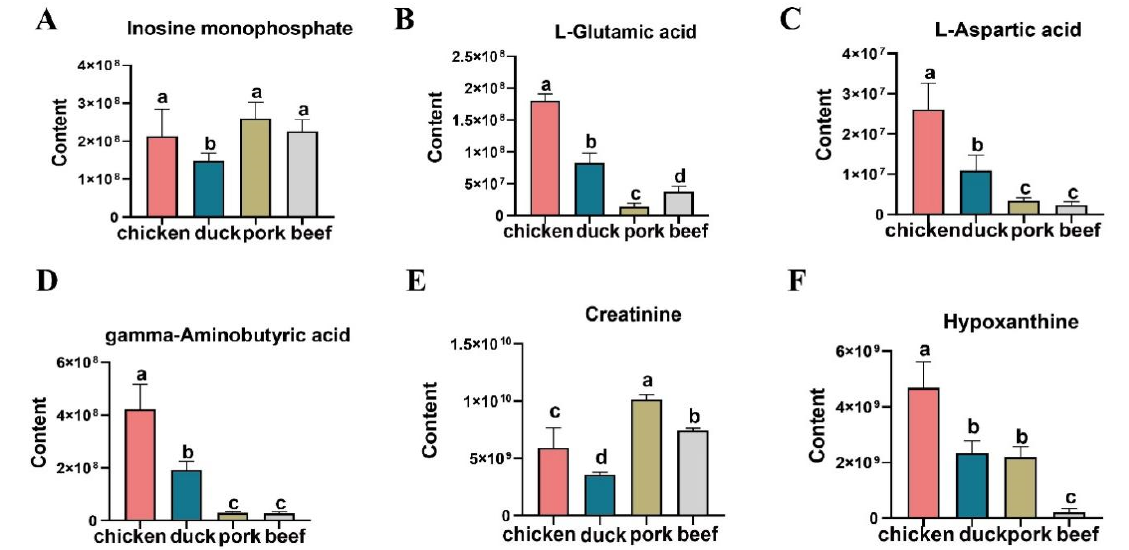
Figure 5. Content of key taste contributors in chicken, duck, pork, and beef. ( A – F ) Contents of inosine monophosphate, L-glutamic acid, L-aspartic acid, gamma-aminobutyric acid, creatinine, and hypoxanthine in four livestock species, respectively. The same letter in the figure indicates no significant difference in the content of taste metabolites between species, and different letters indicate a significant difference in the content of taste metabolites between species.